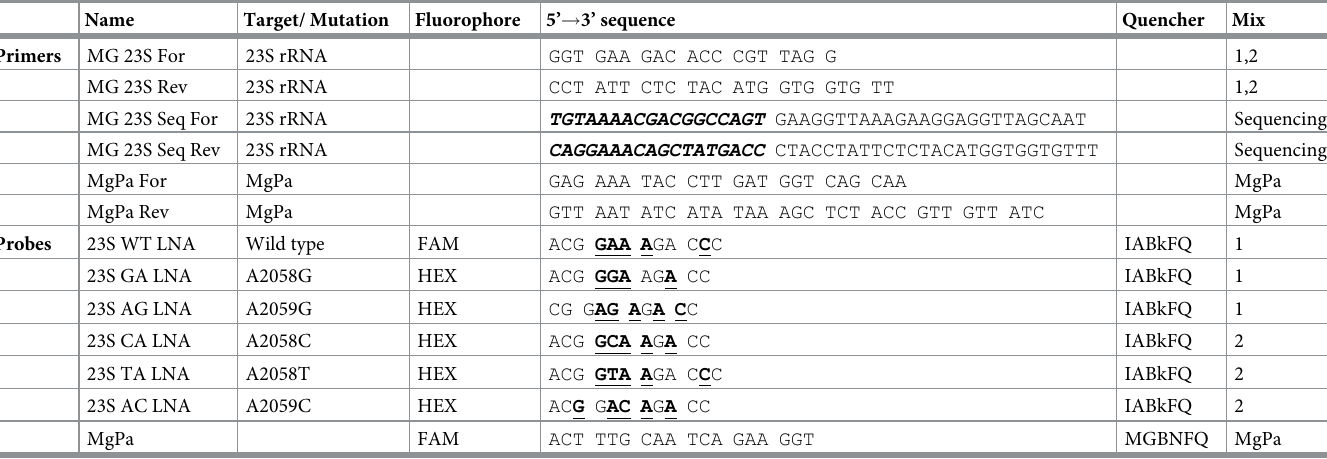
Table 1. Primers and probes for 23S rRNA sequencing, and MG-MRAM and MgPa qPCR.